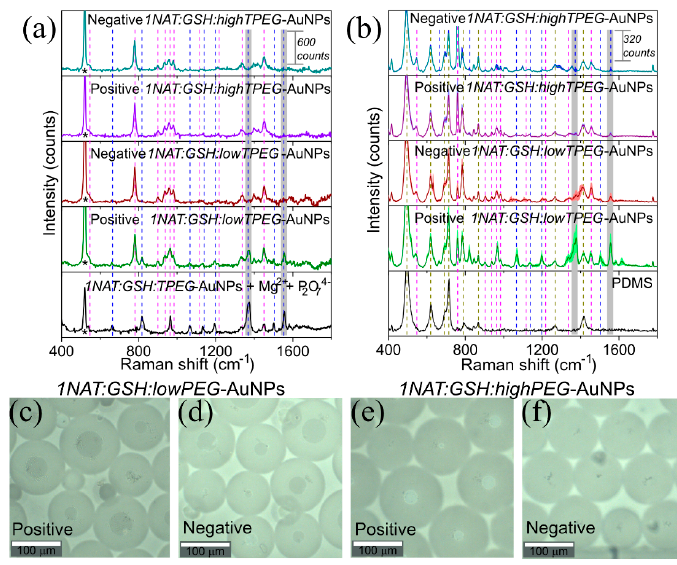
Figure 3. Detection of LAMP by SERS derived from AuNPs aggregation due to the pyrophosphate generation. Briefly, target DNA extracted from L. monocytogenes was amplified in the presence of